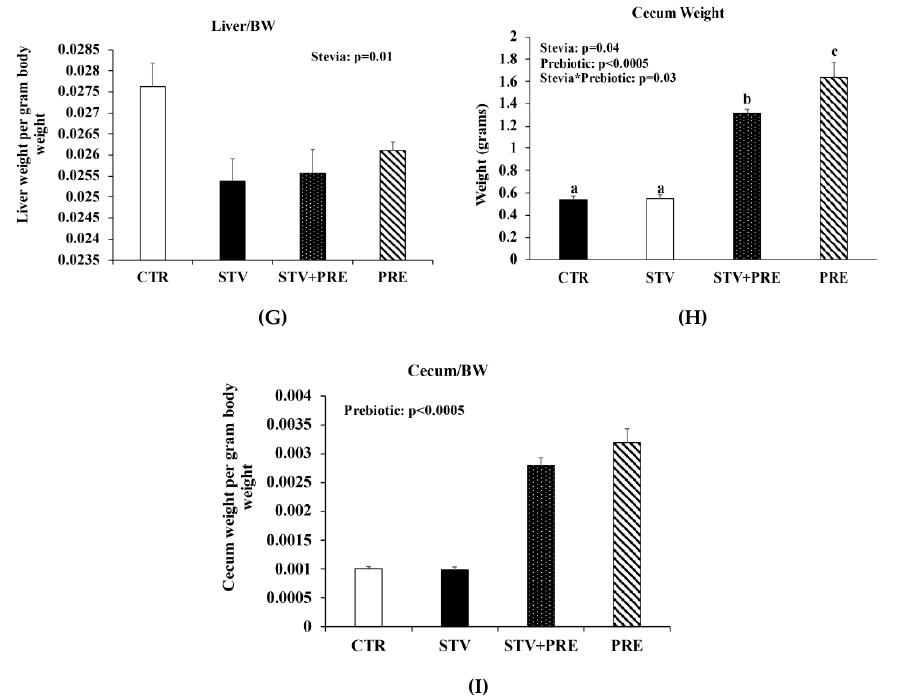
Figure 1. Body weight, body composition, and cecum weight in male rats consuming RebA, prebiotics, both or neither for 9 weeks. (a) Body weight; (b) fat mass; (c) lean mass; (d) final total body weight; (e) percent body fat; (f) liver weight; (g) liver weight per gram of body weight; (h) cecum weight; (i) cecum weight per gram of body weight. Panels B-I were measured at 12 weeks of age. Values are mean ± SEM, n = 8/group. Labelled means without a common superscript letter (a, b, c) differ, p < 0.05. CTR, control; STV, RebA; STV + PRE, RebA and prebiotic; PRE, prebiotic; BW, body weight.